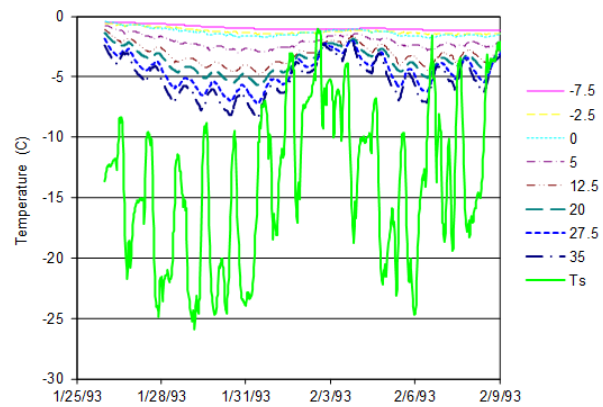
Figure 3. Measured snow, ground, and snow surface temperatures at the USU drainage farm. T s is the measured surface temperature of snow from an infrared sensor. Other temperatures are from ther- mocouples labeled according to their height relative to the ground surface. Negative heights are below the ground surface and positive heights above the ground surface. 0 refers to the measured temper- ature at the ground